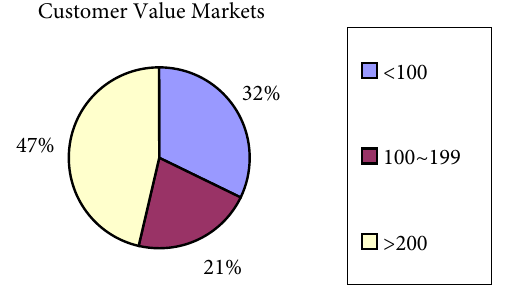
Fig. 2. Customer value markets for an online travel agency in Taiwan, 2013 (Jan. ~